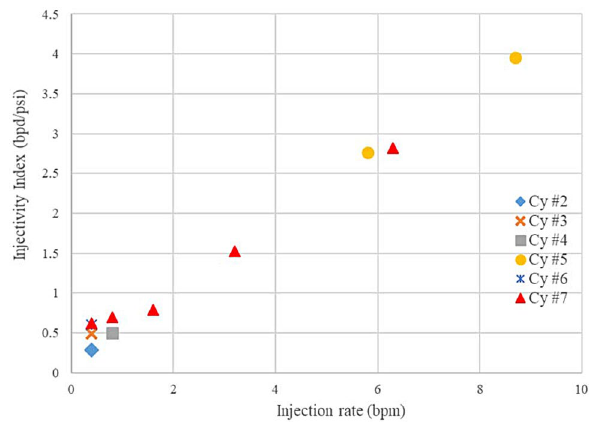
Fig. 24 Log–log diagnostic plot for the DFIT test simulation with a single fracture with dip direction of 25°. The semilog drawdown derivative curve departs from early unit slope (storage) and estab- lishes a − 1/4 slope. − 1/2 slope on the semilog drawdown derivative curve (in log–log plot) represents fracture linear flow. Drawdown derivative is (∆ t d∆ P /d∆ t ), and semilog derivative is referring to the Bourdet derivative